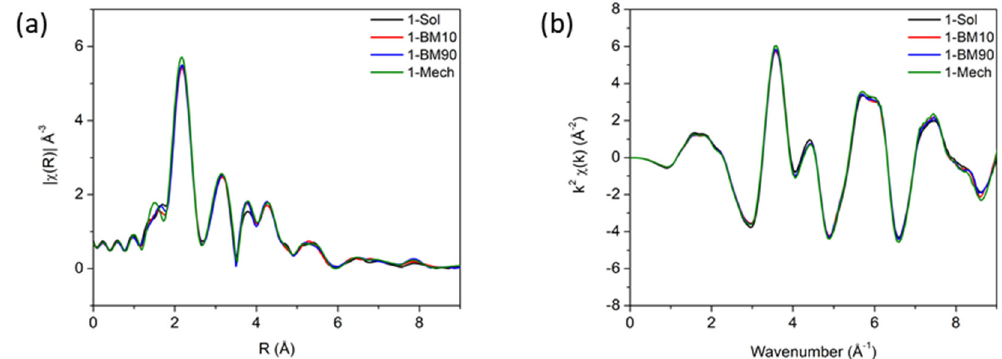
Figure 2. ( a ) k 3 weighted pseudo-radial distribution function of Fe K-edge spectra for 1-Sol , 1-BM10 , 1-BM90 and 1-Mech. ( b ) Combined Fe-Edge K Space EXAFS spectrum (k 3 weighted) for 1-Sol ,